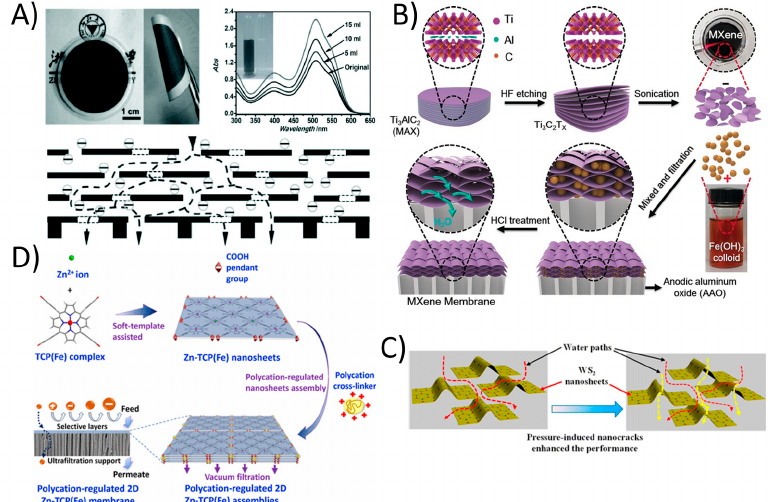
Figure 6. ( A ) Ultrathin ( ≈ 22–53 nm thick) graphene nanofiltration membrane (uGNM) coated on an AAO substrate with schematic illustration of the possible permeation route (reproduced from [115] with permission from the Wiley Online). ( B ) MXene membrane preparation (reproduced from [116] with permission from the Wiley Online). ( C ) The assembly of chemically exfoliated WS2 nanosheets act as an ultrafast separation membrane for small molecules with size of about 3 nm (reproduced from [117] with permission from the American Chemical Society) and ( D ) 2D MOF based defect- free ultra-thin 2DNMs membrane was fabricated by assembly of 2D Zn-TCP (Fe) nanosheets (reproduced from [118] with permission from the American Chemical Society).